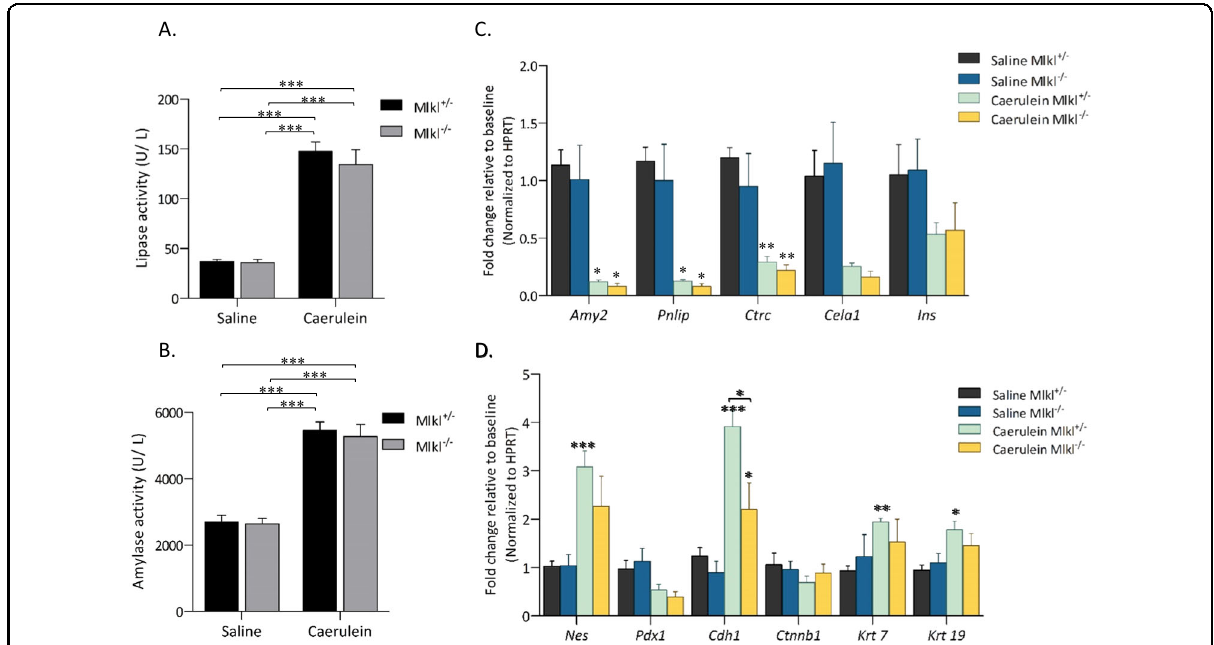
Fig. 3 The expression of pancreatic digestive enzymes. Serum lipase ( A ) and amylase activity ( B ) were determined in serum collected after 12 h of treatment with saline or caerulein ( n = 5 − 6 in each group). The results of qPCR analysis of mRNA expression in pancreatic tissue are shown in C , D . Pancreatic digestive enzyme genes ( Amy2 , Pnlip , Ctrc , Cela1 , and Ins), genes associated with pancreatic development ( Nes and Pdx1 ), and ductal and epithelial cell-associated genes ( Cdh1 , Ctnnb1 , Krt7 , and Krt19) were examined ( n = 6 in each group). The data are presented as the means ± SEMs. * P < 0.05, ** P < 0.01, and *** P < 0.001 compared to the control group. These data are representative of three